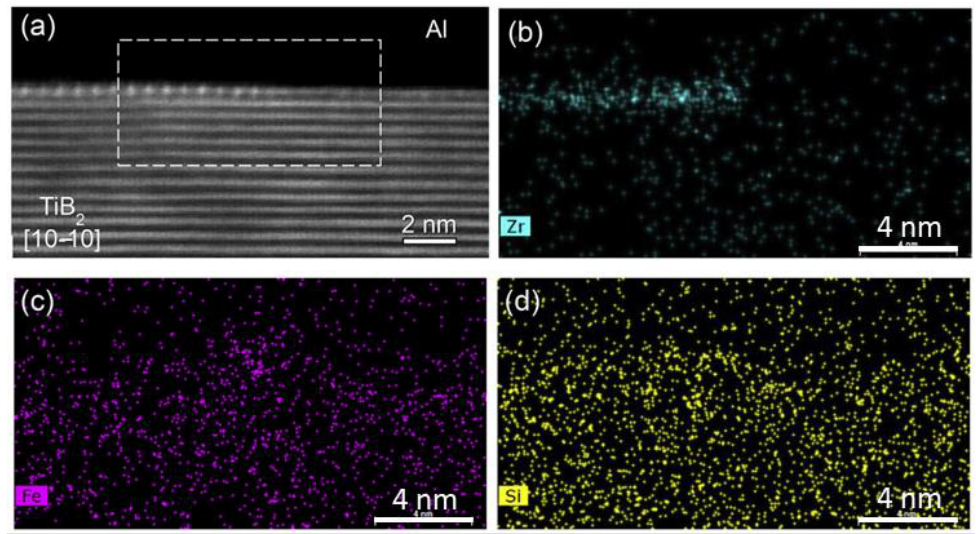
Figure 14. On-going of the Zr segregation process [26]. ( a ) STEM HAADF image across Al/TiB 2 interface viewed along [1 0 1 ̅ 0] TiB 2 direction, and ( b – d ) super-X EDS elemental mapping of ( b ) Zr, ( c ) Fe and ( d ) Si, showing the formation of Zr 2 Ti 2DC layer on the left-hand side, but not yet on the right-hand side of the (0 0 0 1) TiB 2 surface.